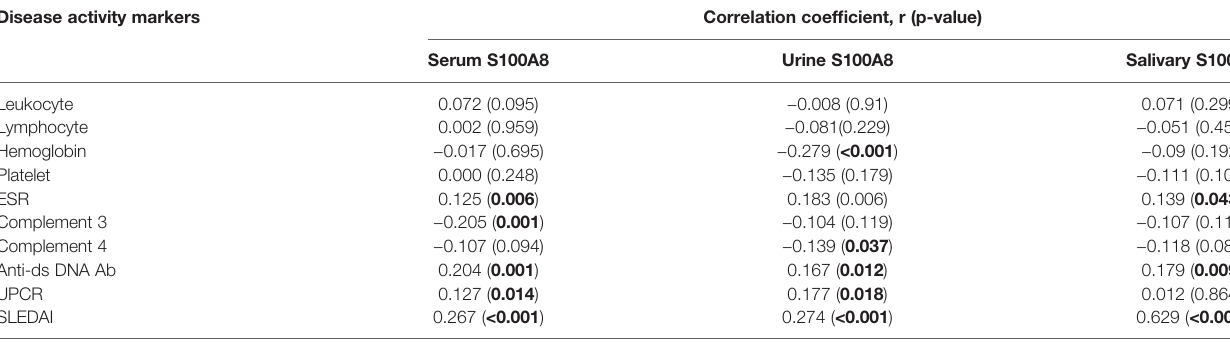
Bold values indicate signi fi cant p-values. SLE, systemic lupus erythematosus; ESR, erythrocyte sedimentation rate; dsDNA, double-strand deoxyribonucleic acid; Ab, antibody; UPCR, urine protein/creatinine ratio; SLEDAI, SLE disease activity